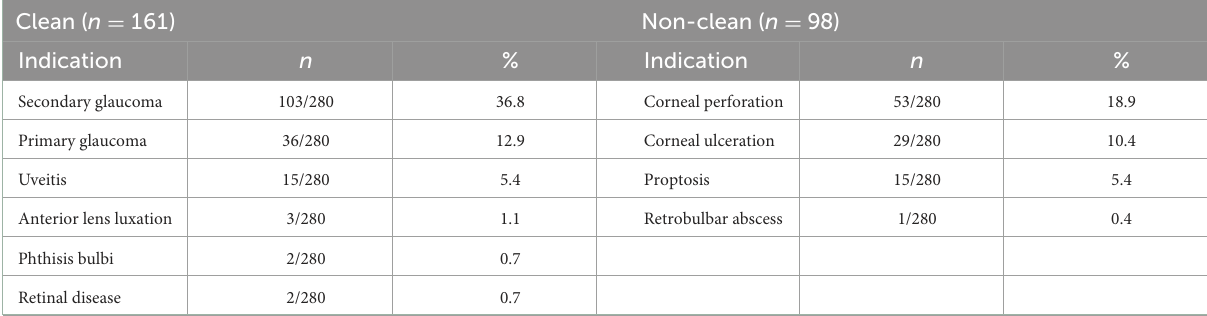
TABLE 1 Clean vs. non-clean indications for enucleation in the study cohort including percentage of overall population ( n = 280). Clean ( n =